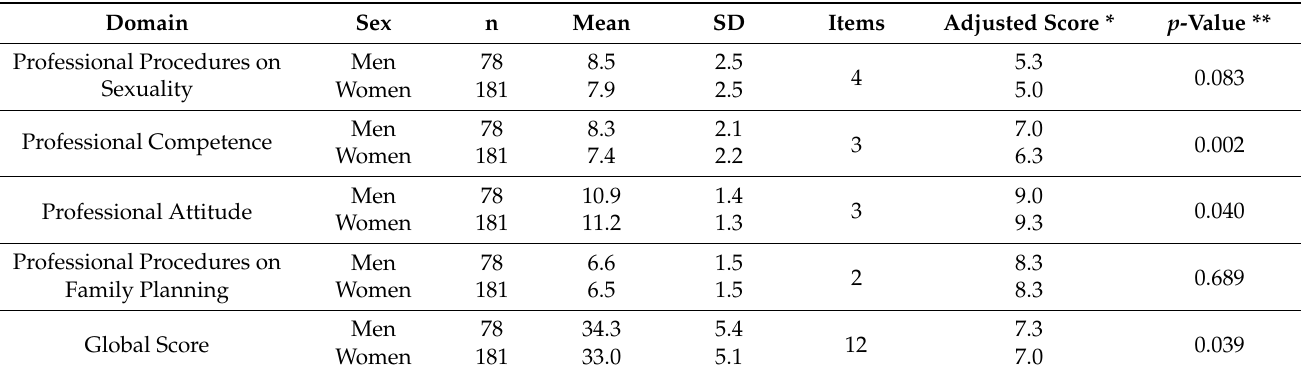
Table 10. Scores regarding the sex of the participants.